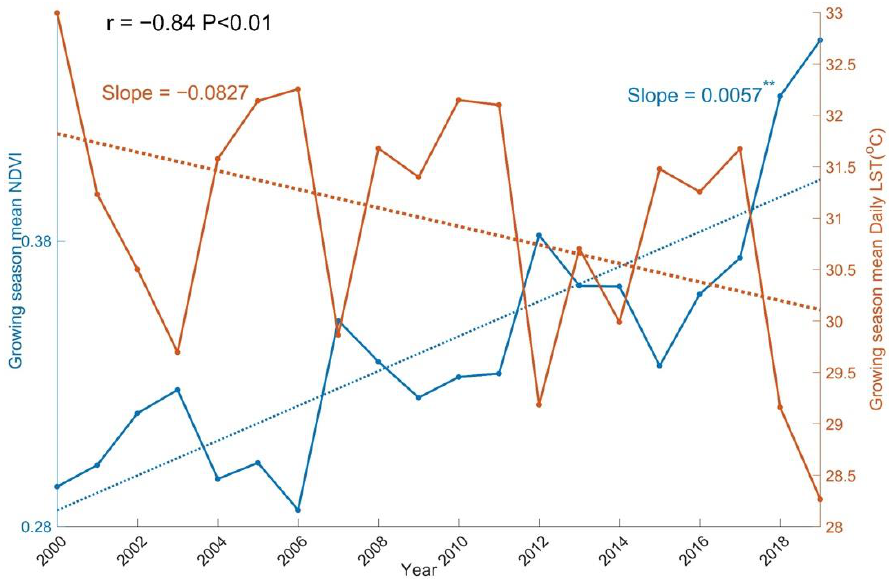
Figure 9. Interannual variation of the growing season vegetation greenness and land surface tem- perature. Two asterisks indicate that the slope is at the 1% level of statistical significance.